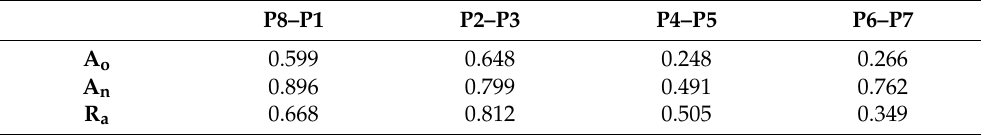
Figure 4. As in Figure 3 but for normalized hourly precipitation deviation in ( a ) P8–P1, ( b ) P2–P3, ( c ) P4–P5 and ( d ) P6–P7 averaged in DJF 2011–2020. Table 1. Diurnal amplitudes from precipitation (A o , mm h − 1 ) and from normalized precipitation (A n ) averaged within − 100–0 km offshore via sinusoidal regressions, together with R a (mm h − 1 ) calculated as A o divided by A n .